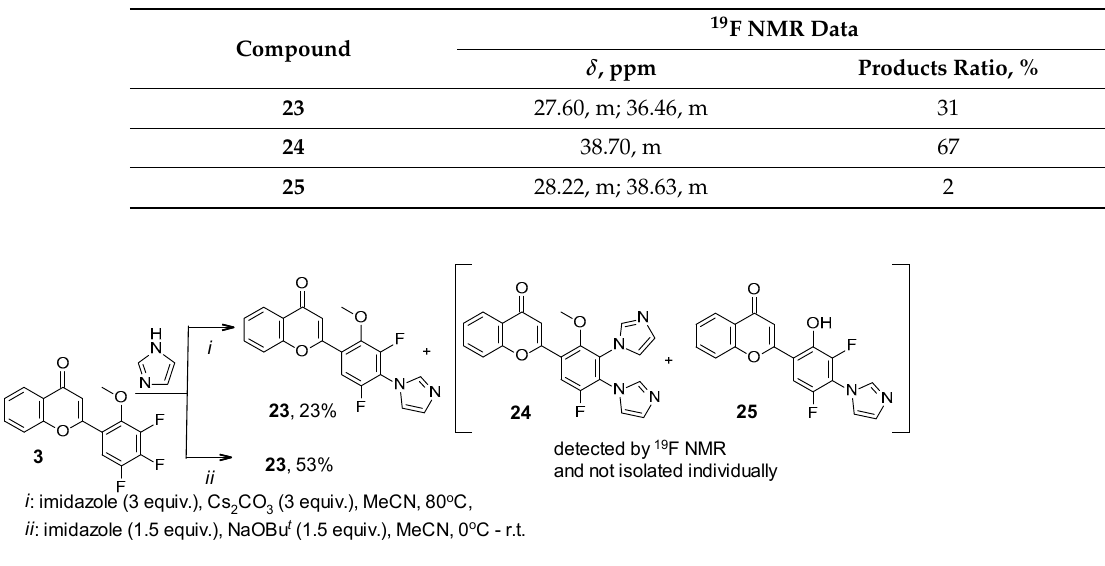
19 F NMR Data δ , ppm